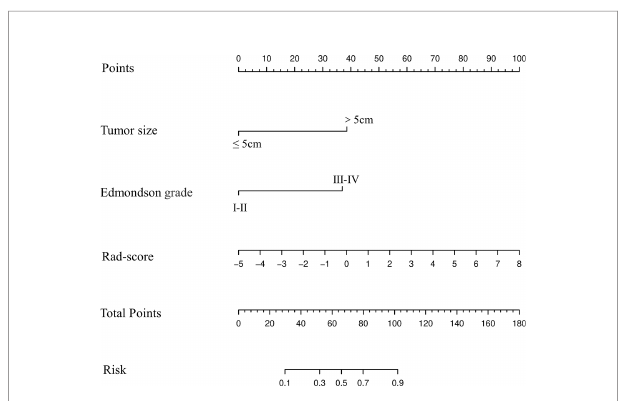
FIGURE 6 | Development and performance of the nomogram based on the combined model in predicting the risk of ER in HCC patients after partial liver resection.